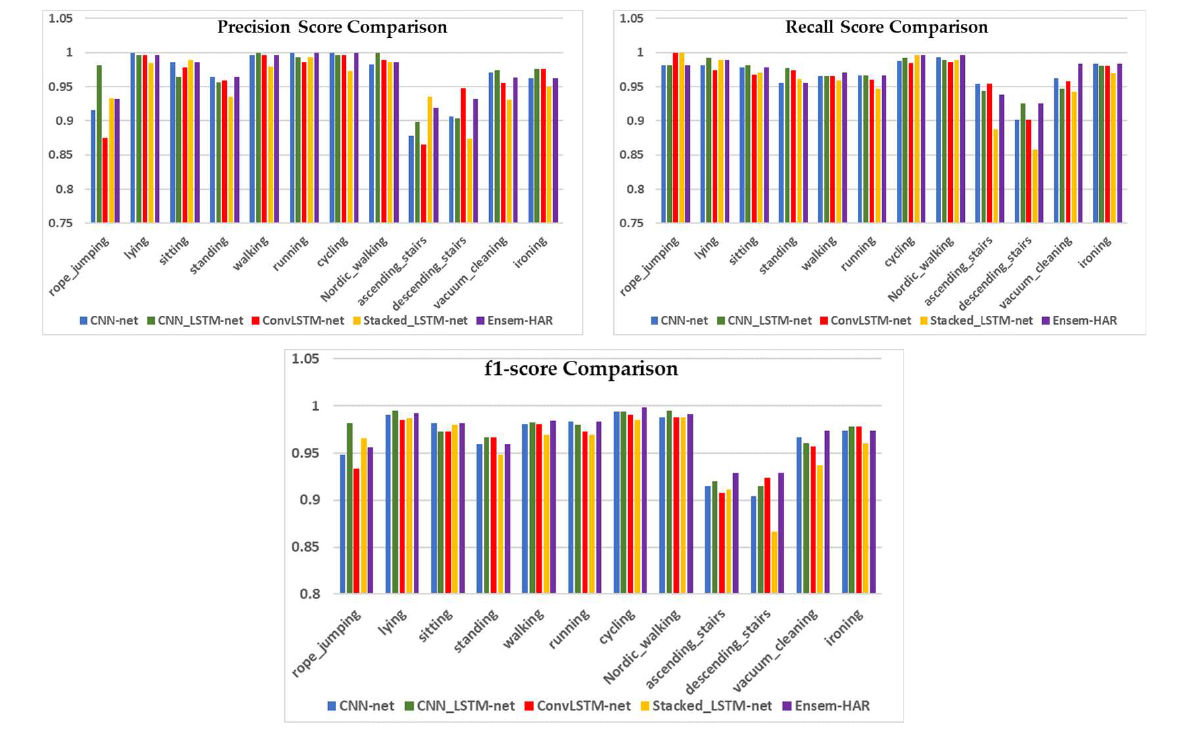
Figure 16. Graphical comparison of performances for each activity class with respect to Precision,